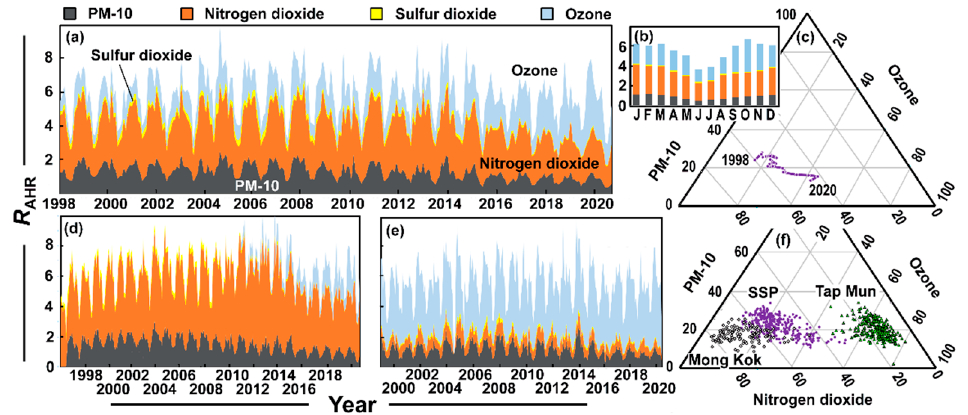
Figure 3. ( a ) Added contributions to the health risk ( R AHR ) from PM 10 , NO 2 , SO 2 , and O 3 at Sam Shui Po, (colloquially SSP). ( b ) Monthly averages of health risk for the pollutants for the years 2015–2019. ( c ) Ternary diagram showing average annual health risk from PM 10 , NO 2 , and O 3 at Sam Shui Po from 1998–2020. ( d ) Added contributions to the health risk from PM 10 , NO 2 , SO 2 , and O 3 at the Mong Kok roadside site. ( e ) Added contributions to the health risk from PM 10 , NO 2 , SO 2 , and O 3 at the rural site on Tap Mun (Grass Island). ( f ) Ternary diagram showing average monthly health risk from PM 10 , NO 2 , and O 3 at Sam Shui Po (1998–02/2020-09), Mong Kok (2011-01/2020-09), and Tap Mun (1998-01/2020-04). Note: (i) scale change between Figure 3a,d,e (ii) color/shades and order for the pollutants plotted remain the same for Figure 3a,b,d,e.